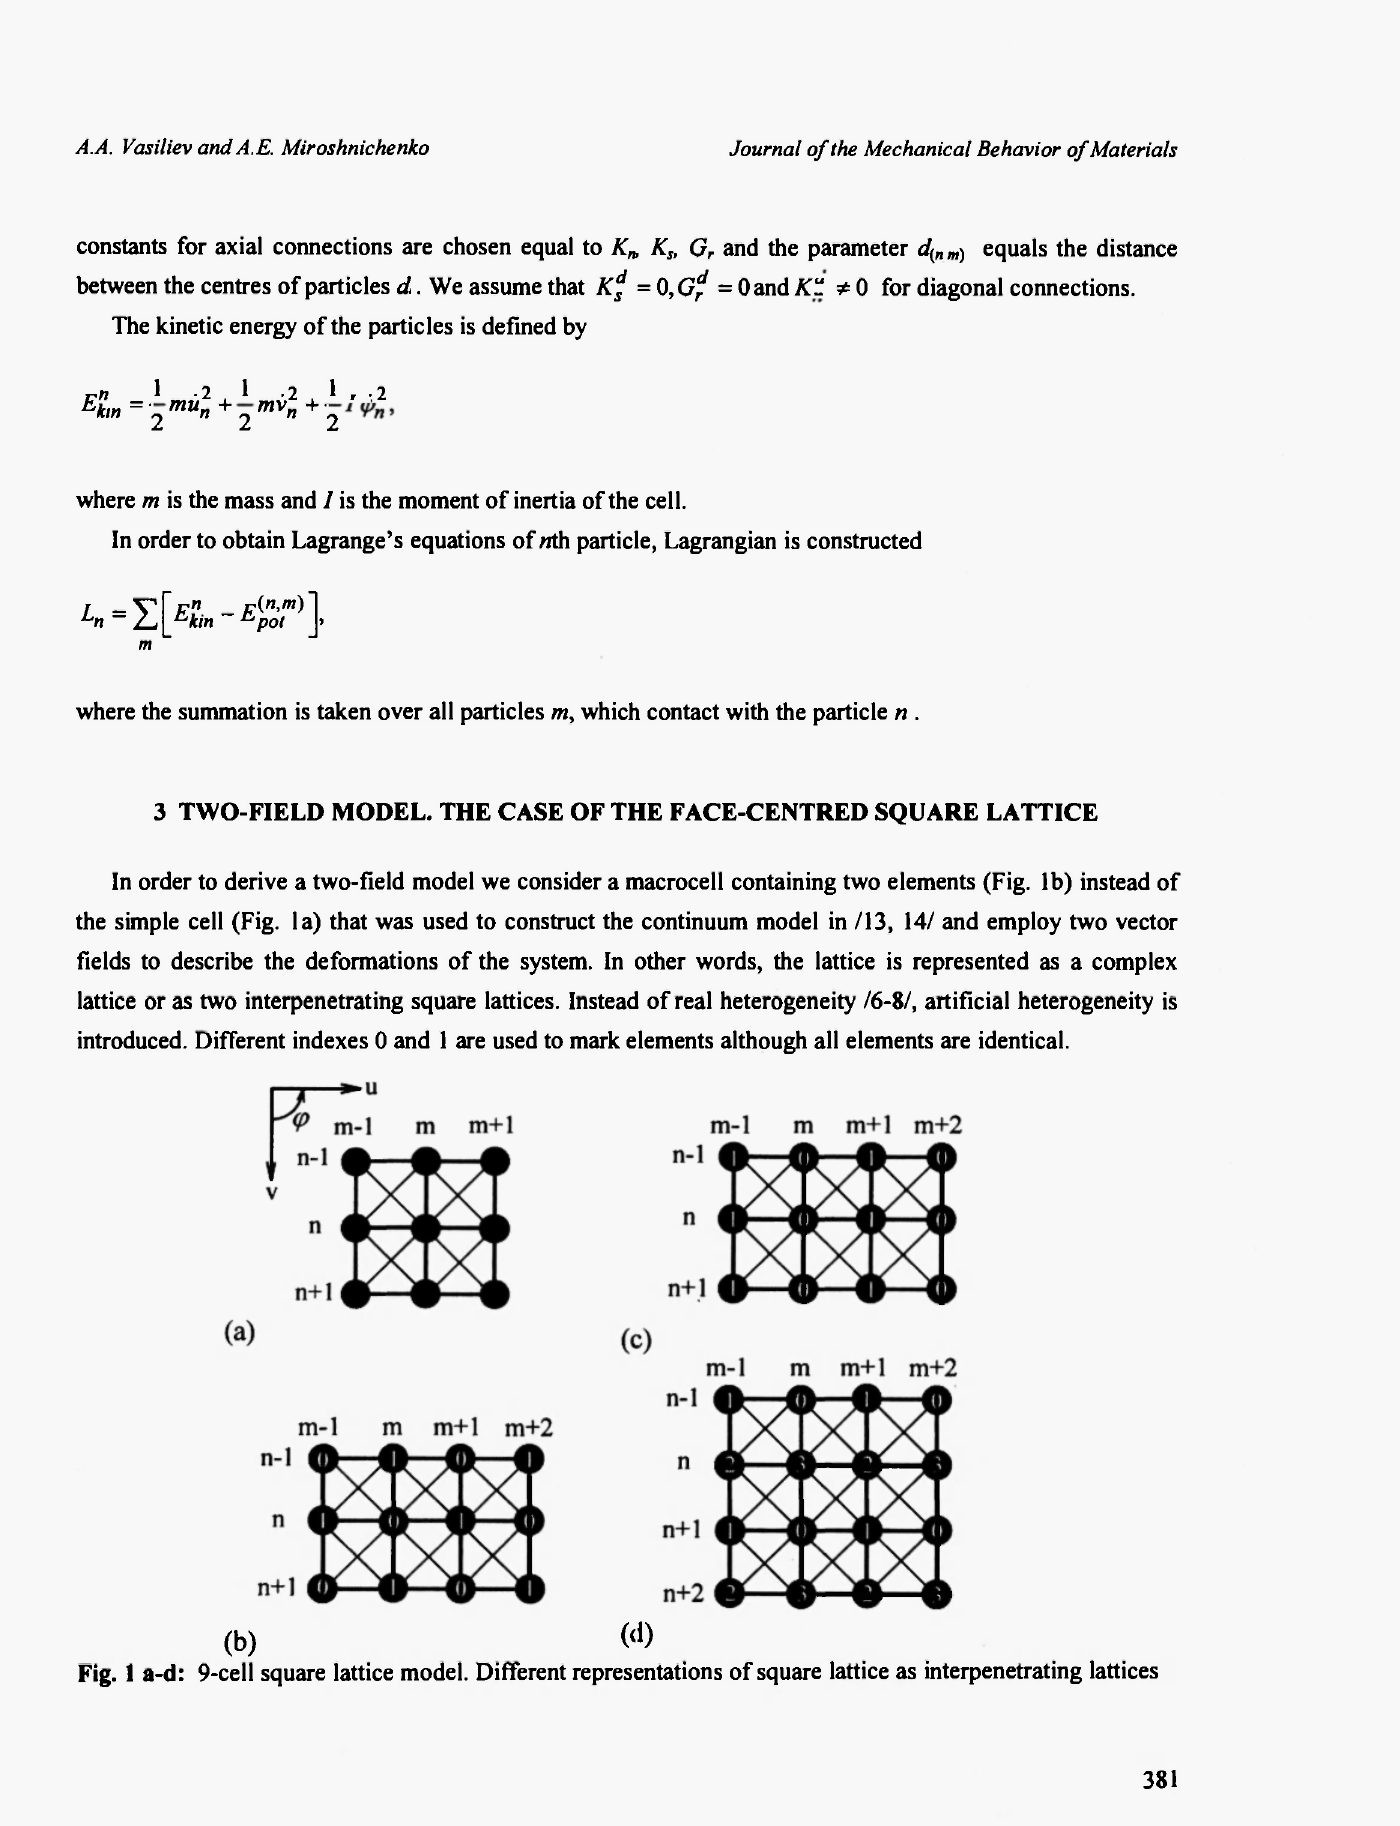
Fig. 1 a -d: 9-cell square lattice model. Different representations of square lattice as interpenetrating